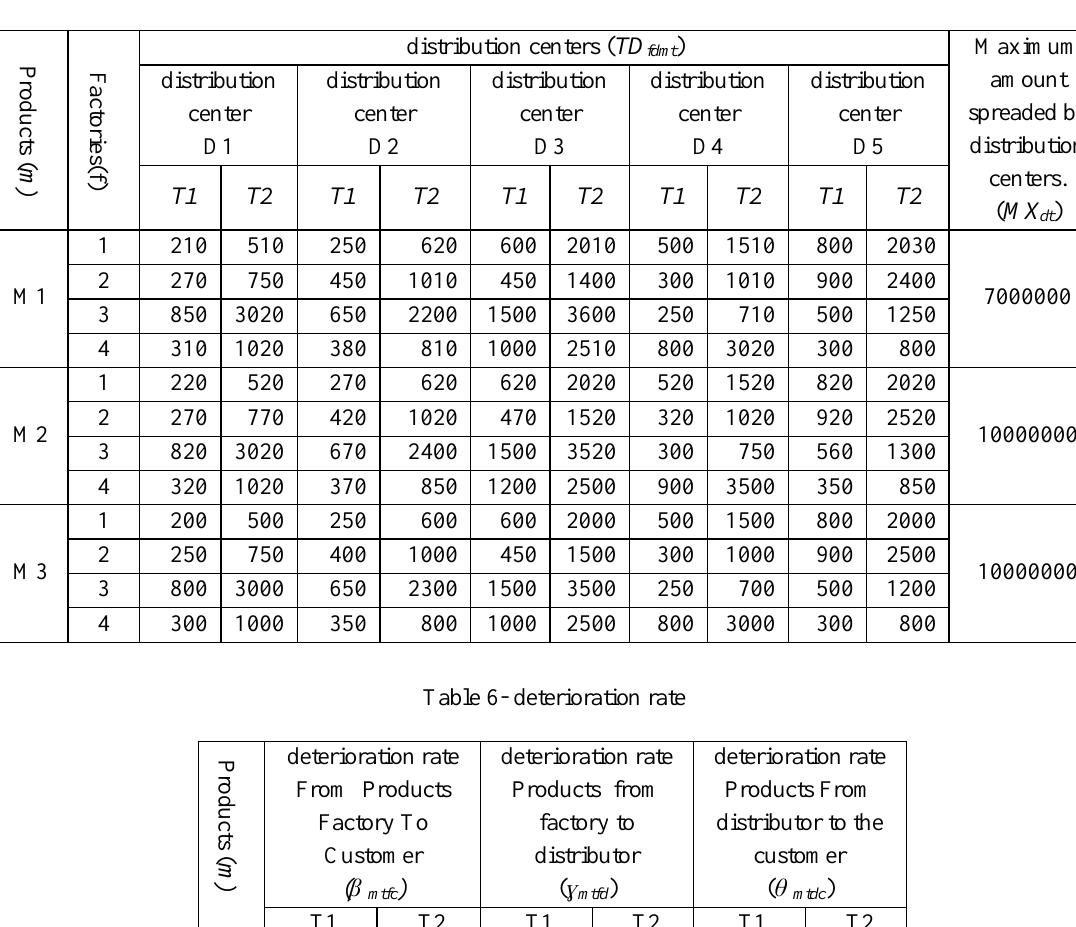
Table 5 - The costs of transportation end products from the factory to the distribution centers and maximum amount spread by any distribution centers.